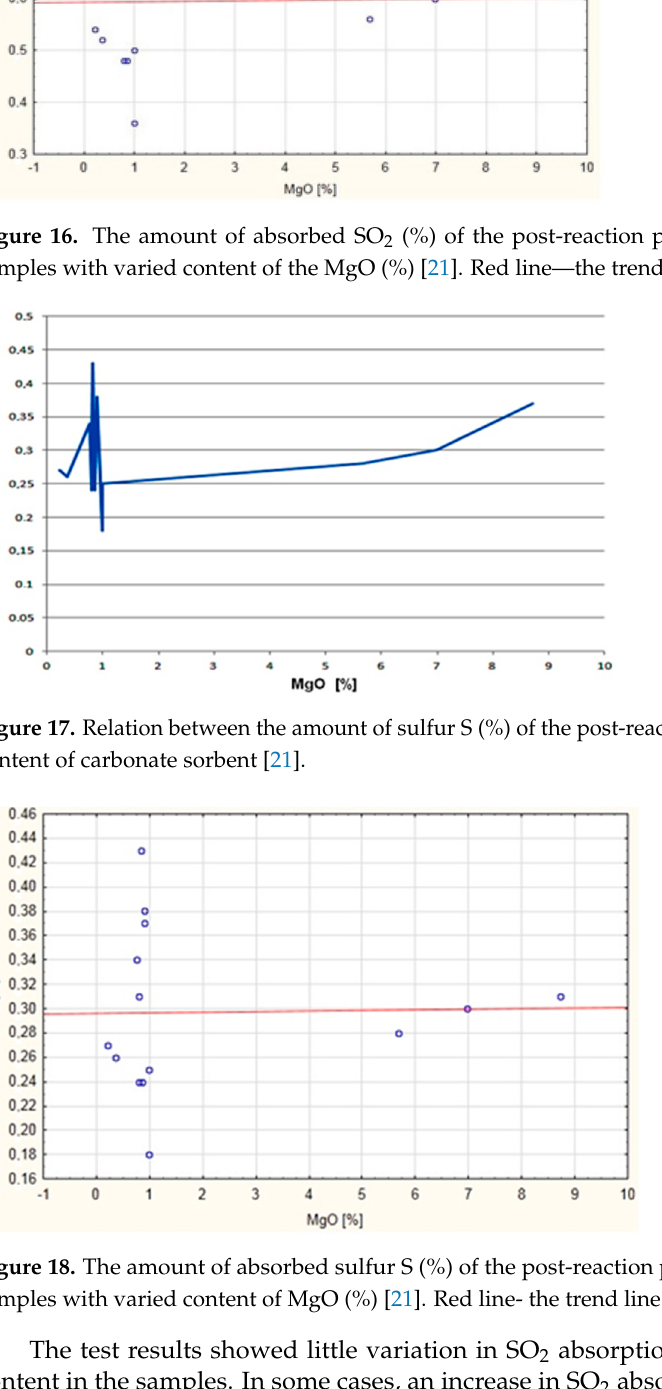
Figure 16. The amount of absorbed SO 2 (%) of the post-reaction product by carbonate sorbent sam-